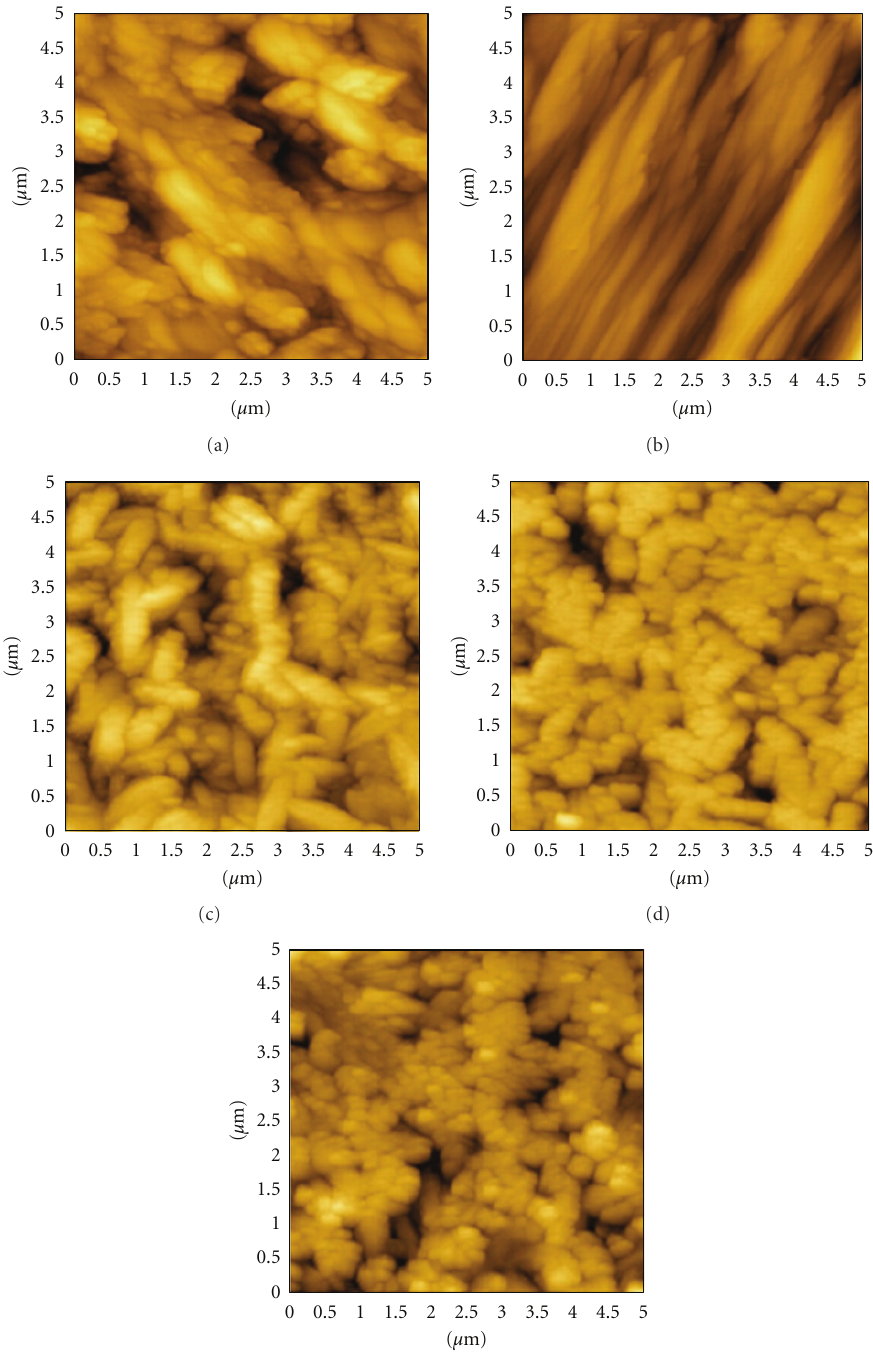
Figure 4: AFM image of sample B (a), E (b), F (c), G (d), and H (e) at 5 × 5 μ m